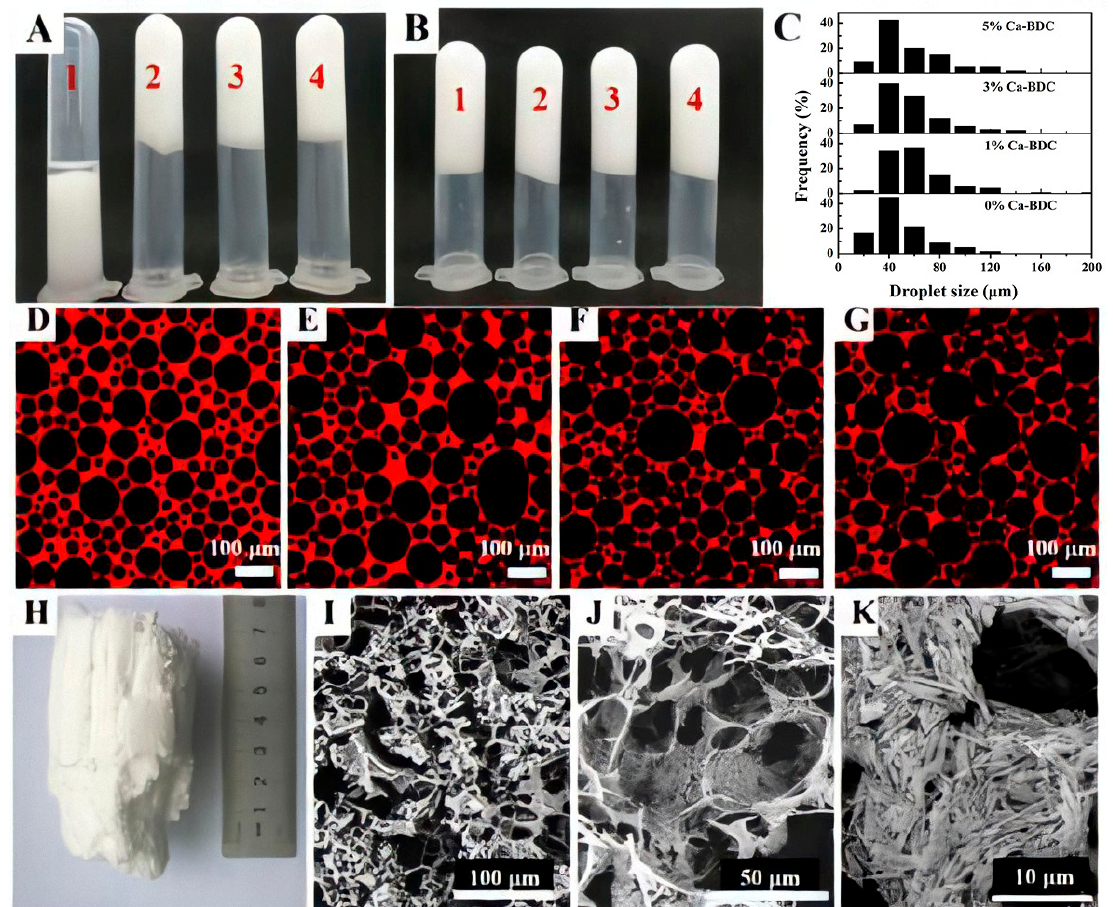
Figure 1. ( A ) Calcium-terephthalate (Ca-BDC) solely emulsified oil-in-water (O/W) high internal phase emulsions (HIPEs) (1), (2), (3), and (4) containing 1, 3, 5, and 7 wt % of Ca-BDC in absence of polyvinyl alcohol (PVA), respectively; ( B ) Ca-BDC particles co-stabilized O/W HIPEs (1), (2), (3), and (4) containing 0, 1, 3, and 5 wt % of Ca-BDC in presence of PVA, respectively; ( C ) is the droplets size distribution chart; ( D ), ( E ) and ( F ), ( G ) are the confocal laser scanning microscopy (CLSM) images of Ca-BDC co-stabilized O/W HIPE (1), (2), (3), and (4); ( H ) is the photograph of integral 3D PVA-modified Ca-BDC monolith templated from Ca-BDC co-stabilized CO2-in-water (C/W) HIPE in the presence of PVA; ( I ) and ( J ) are the SEM images of the microstructure of integral 3D PVA-modified Ca-BDC monolith; ( K ) is a magnified view of (J) to show the separated ultra-fine Ca-BDC nano-rods.